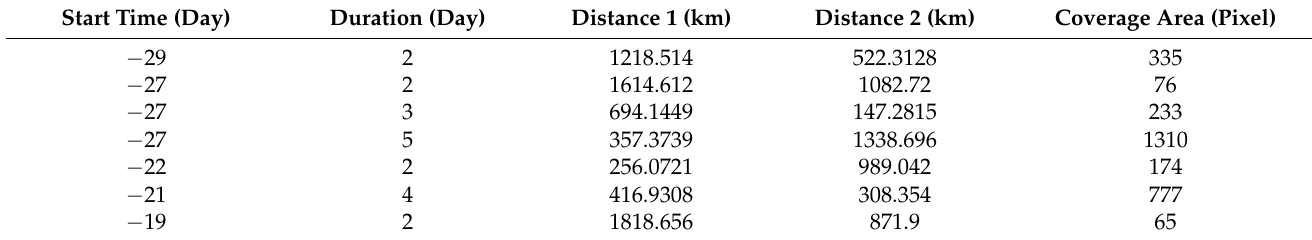
Table 5. The information on anomalies from 20 April 2021 to 20 May 2021